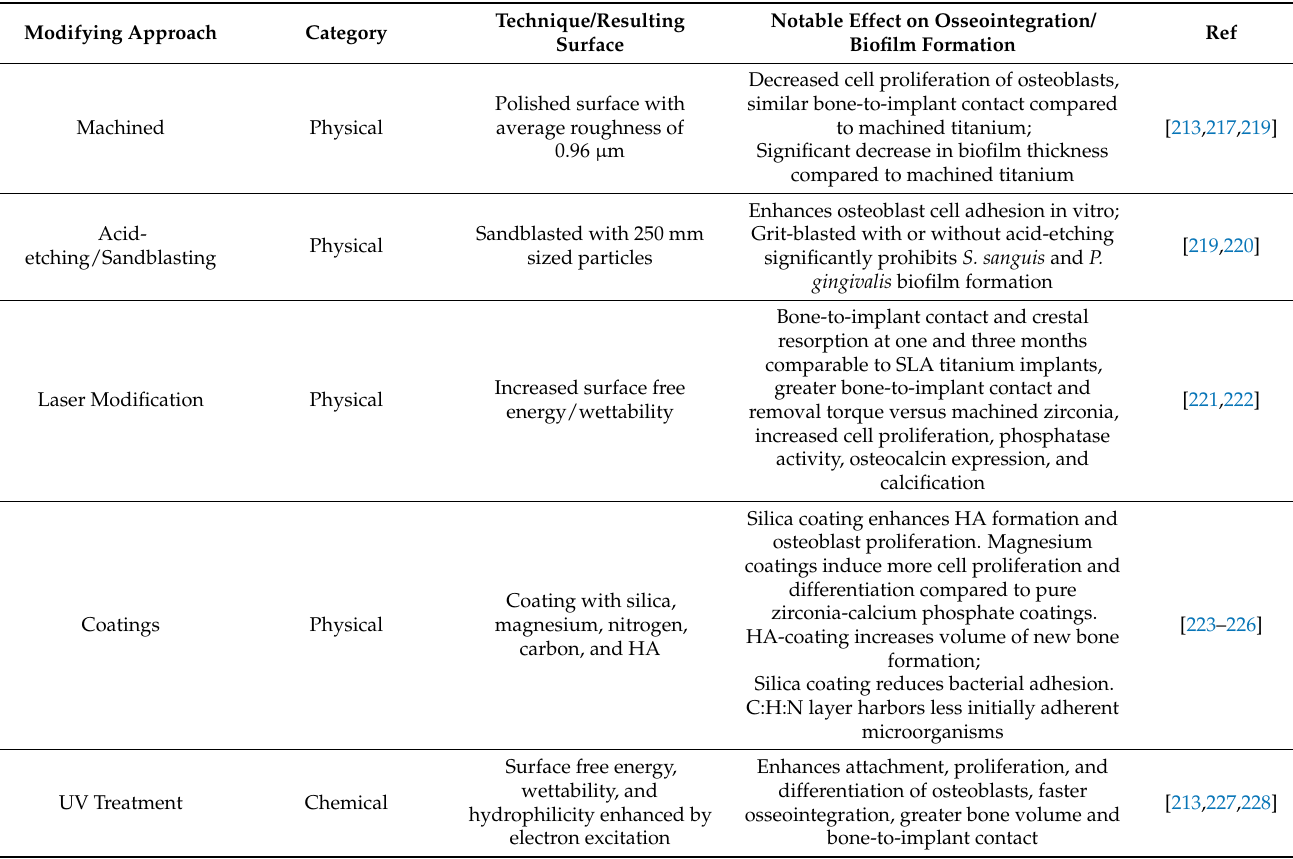
Table 2. The list of zirconia implants’ surface modification